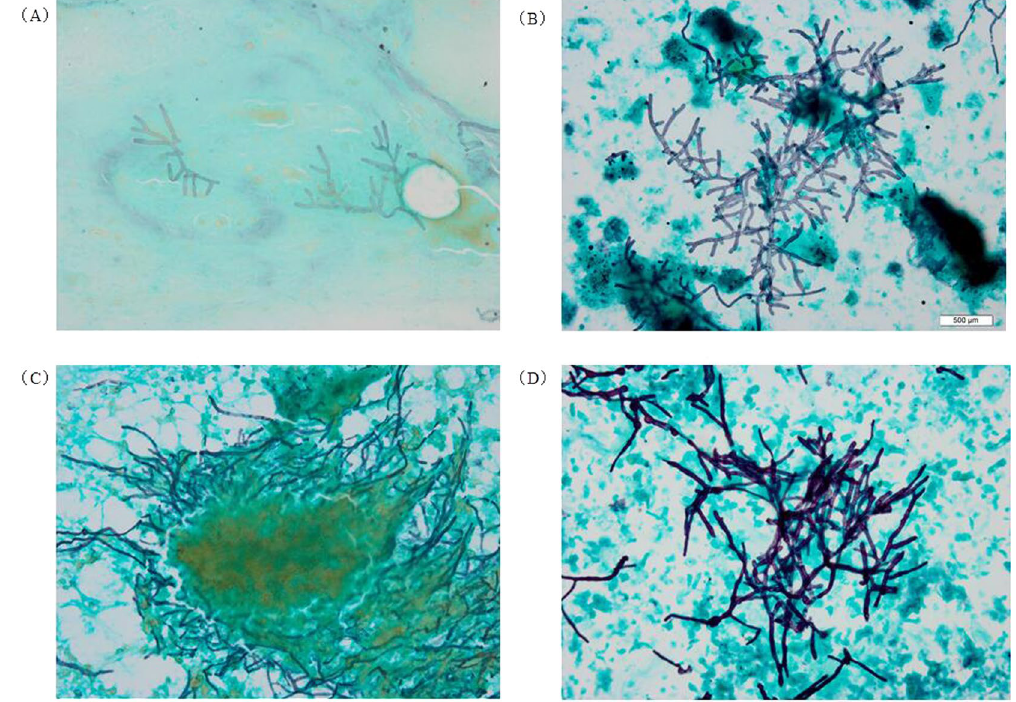
Figure 3. Cytomorphology of Aspergillus in bronchial brushing samples processed using the SurePath LCT platform or conventional cytopathology, followed by GMS staining. The mycelium of Aspergillus appeared brown-black after GMS staining. Magnification, 400X. ( A ) Conventional GMS on sputum samples; ( B ) LCT- based GMS on sputum samples; ( C ) Conventional GMS on bronchial brushing samples; ( D ) LCT-based GMS on bronchial brushing samples. LCT: Liquid-based cytopathology; GMS: Grocott’s Methenamine Silver.